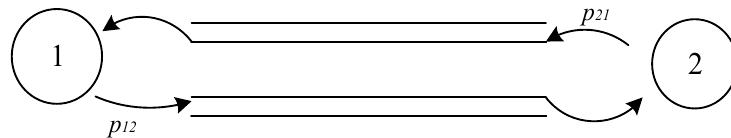
Figure 1. Traffic network diagram of two stations.